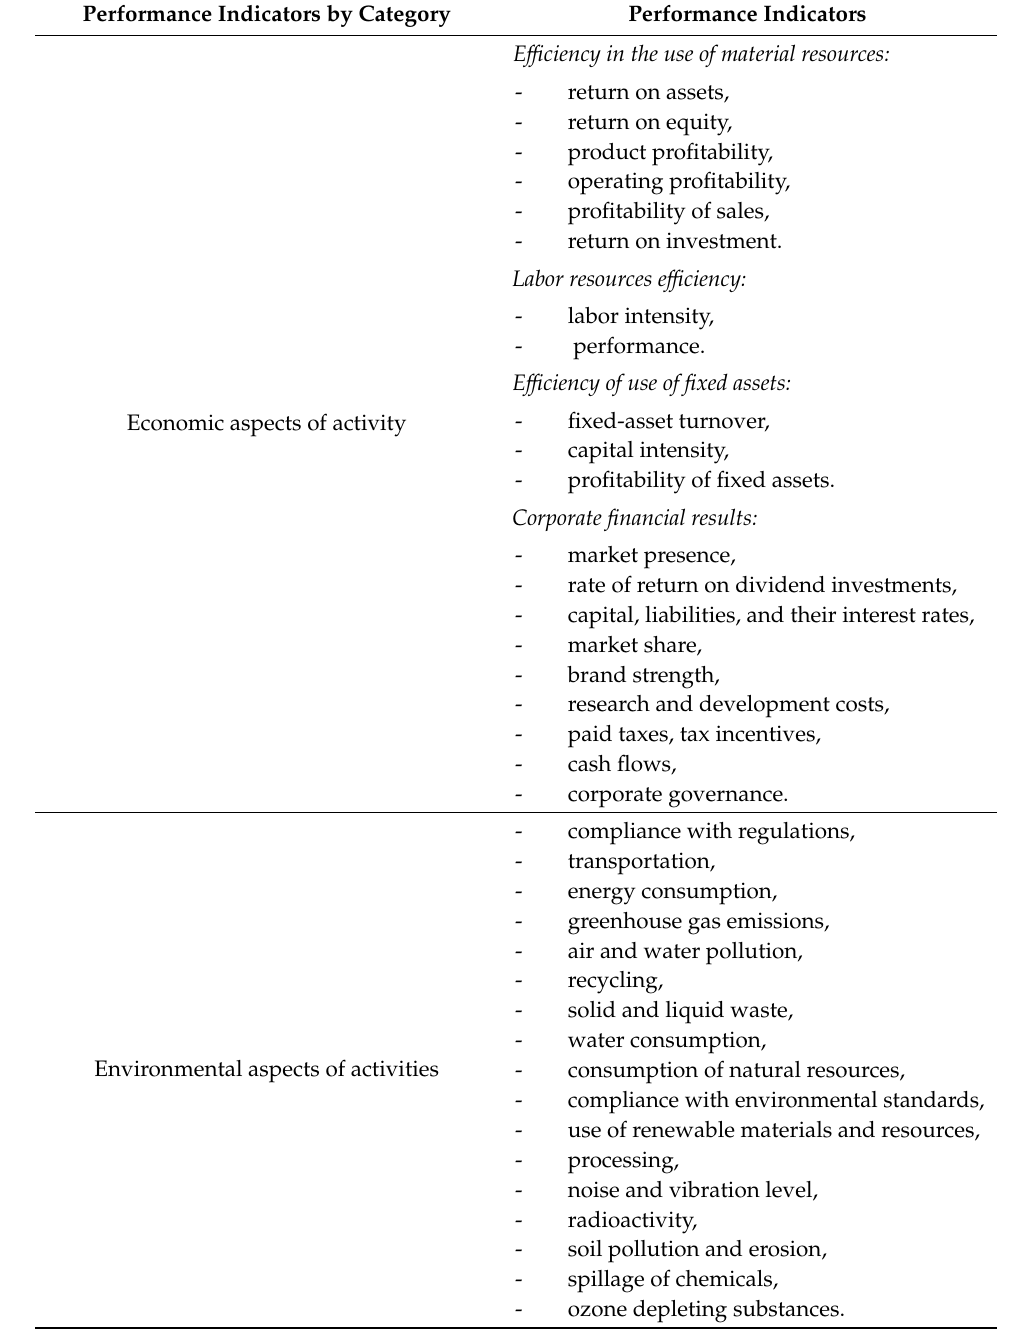
Table 1. Indicators of economic, environmental, and social aspects of the performance of energy